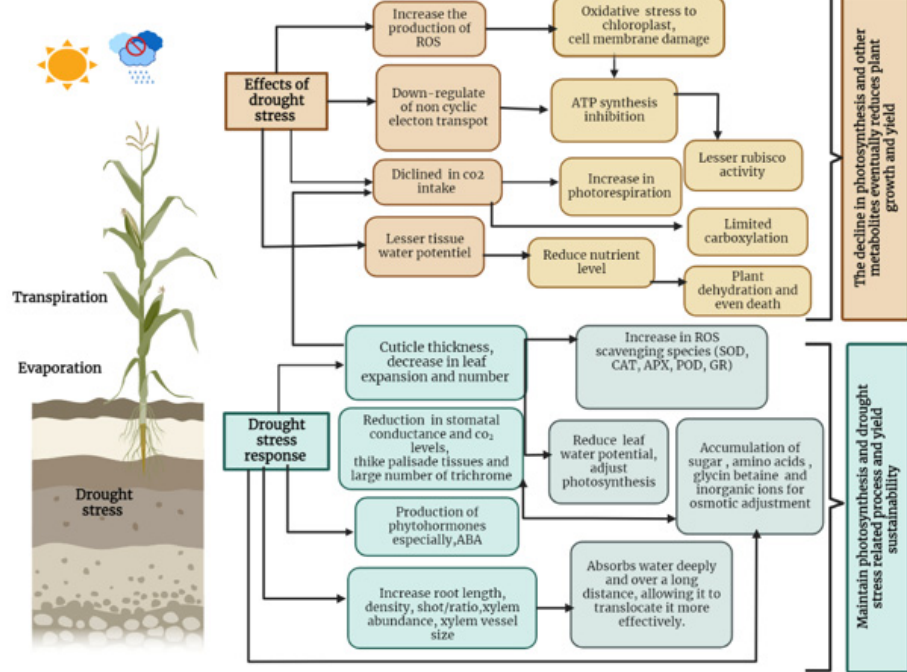
Figure 1. Effects of drought on plant growth and plant adaptation mechanisms.